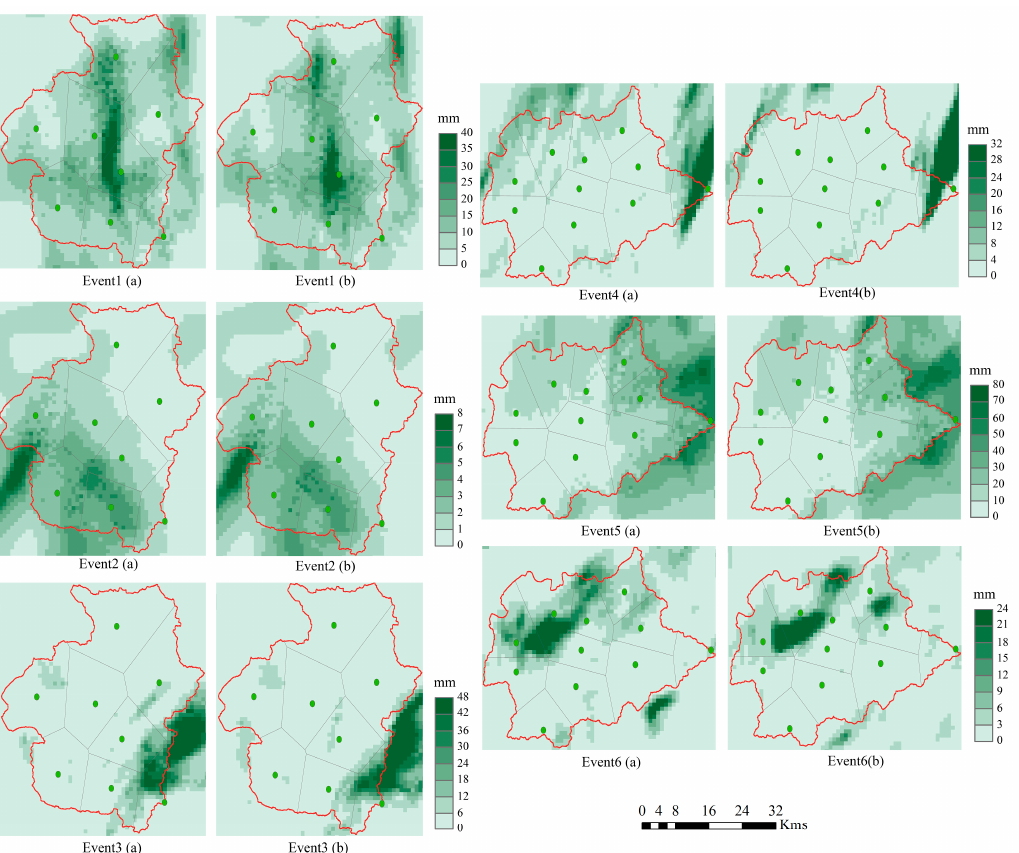
Figure 13. Spatial distributions of the 24 h cumulative runoff of the four soil layers: ( a ) WRF-only; ( b ) the fully coupled WRF/WRF-Hydro.